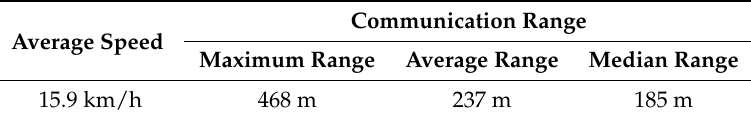
Table 2. Tractors average speed and radio-contact